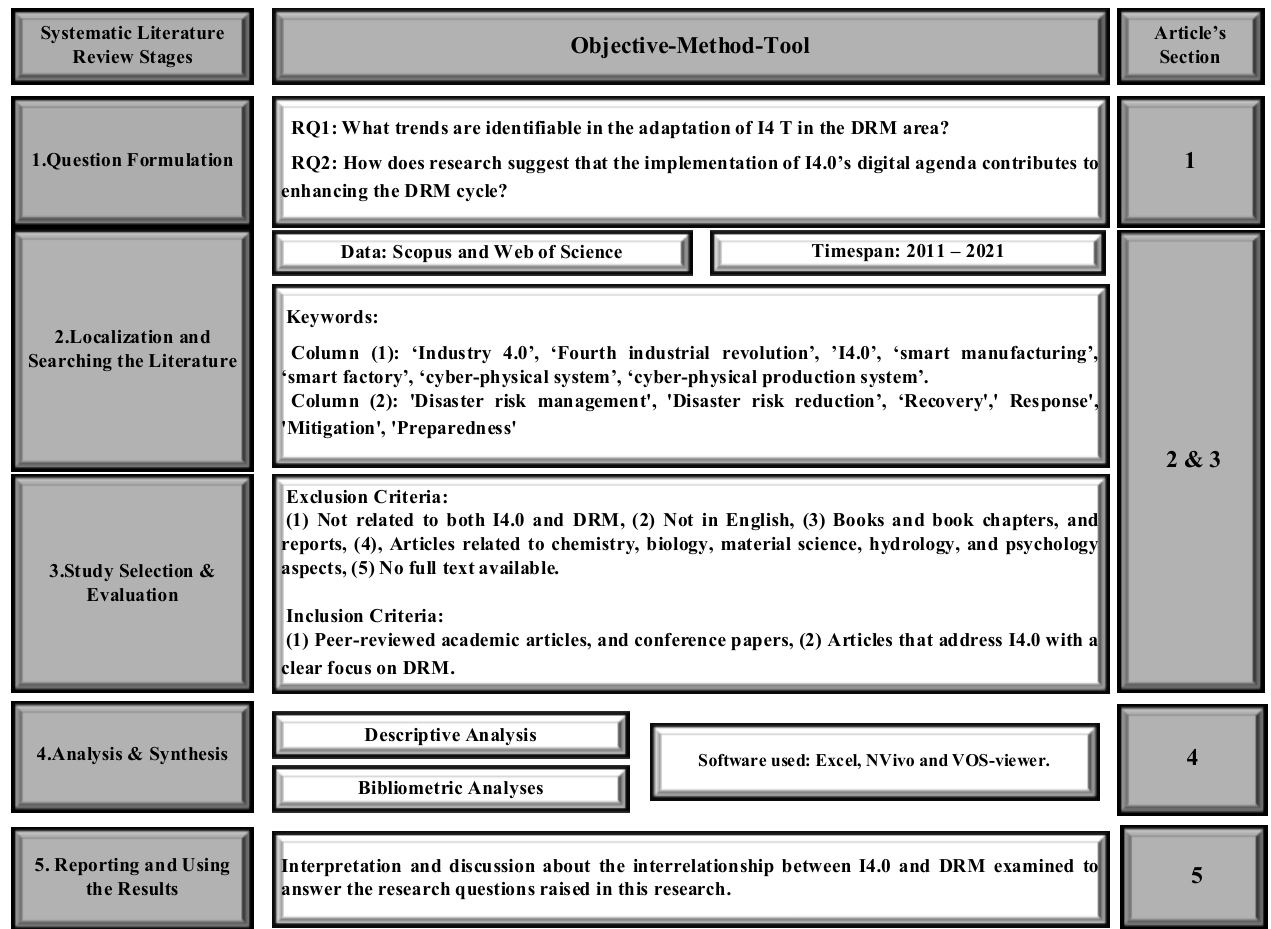
Figure 1. Summary of the systematic literature review stages and processes adapted from Garza-Reyes [30].